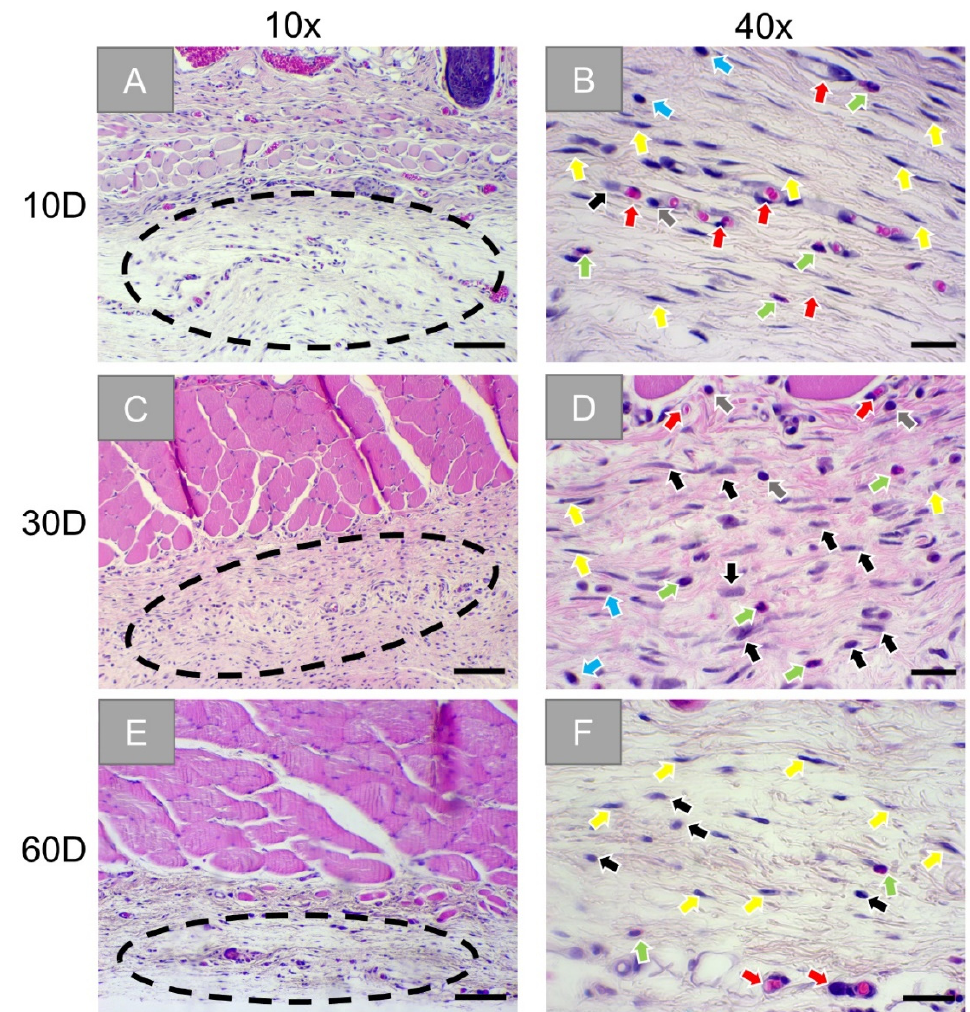
Figure 5. Exemplary histological images of the tissue reactions in the sham operation group at three timepoints: 10 days (first row: A , B ), 30 days (second row: C , D ), and 60 days (third row: E , F ). Dotted circles: wound areas, black arrows: macrophages, red arrows: blood vessels, green arrows: granulocytes, grey arrows: lymphocytes, yellow arrows: fibroblasts, blue arrow: plasma cells. (HE-stainings, 10× and 40× objective magnifications with scale bars: 100 µm and 20 µm, respectively).